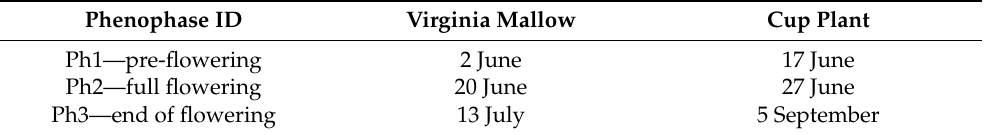
Table 6. Plant sampling dates for analysis of bioactive